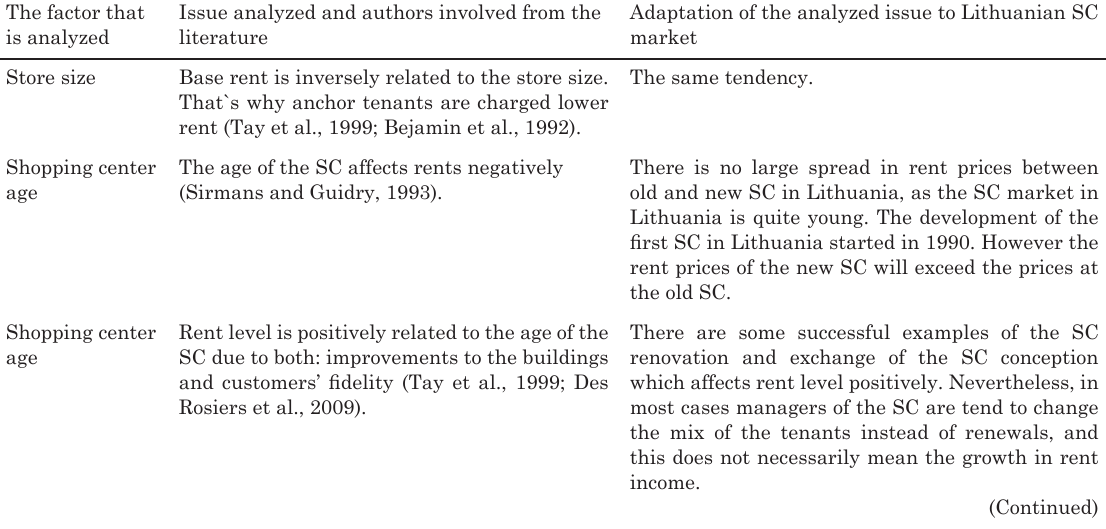
Adaptation of the analyzed issue to Lithuanian SC market